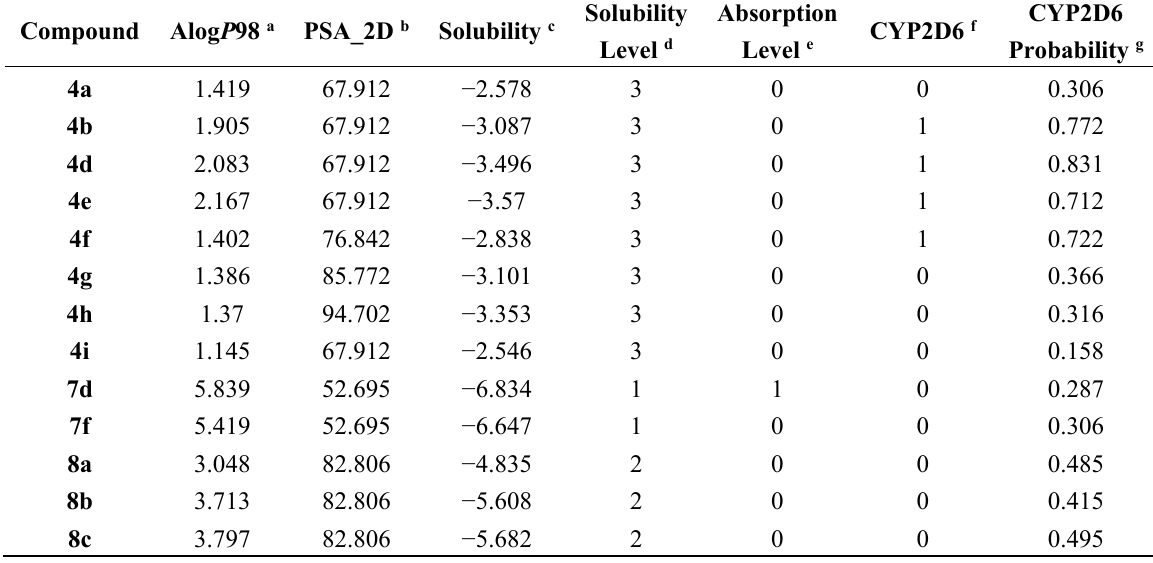
Table 3. Computer aided ADME study of the active